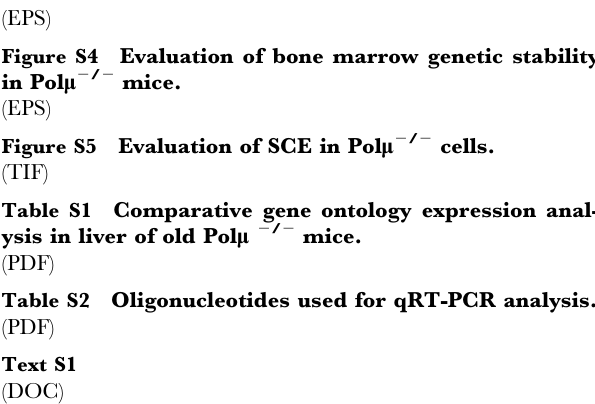
Figure S3 Pol m deficiency alters important longevity indicators.